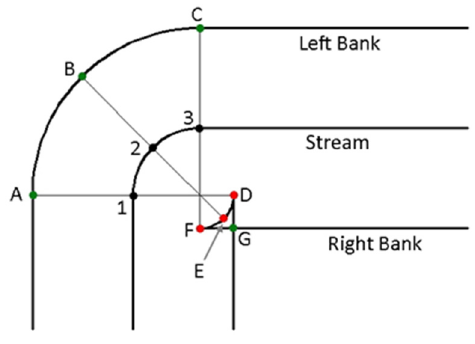
Water 2020 , 12 , x FOR PEER REVIEW Figure 16. Bank definition with parallel offset of the stream. Figure 16. Bank definition with parallel o